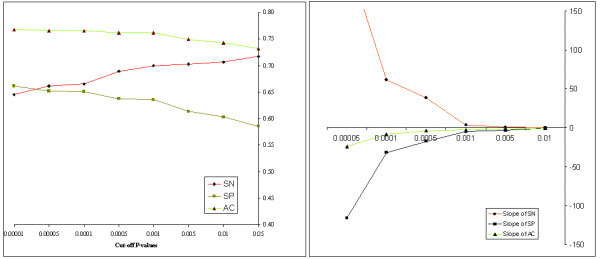
The influence of different choices of cut-off P-values (P0) used in the refinement phase on the sensitivity (SN), the specificity (SP) and the accuracy (AC) of Design-Island applied to a manually curated data set of 1560 putative horizontally transferred genes of Salmonella typhi CT18 generated by Vernikos et al. [21] is shown in Fig. 2A. Fig. 2B shows corresponding variations of slopes of the curves for SN, SP and AC for different choices of cut-off P-values (P0).